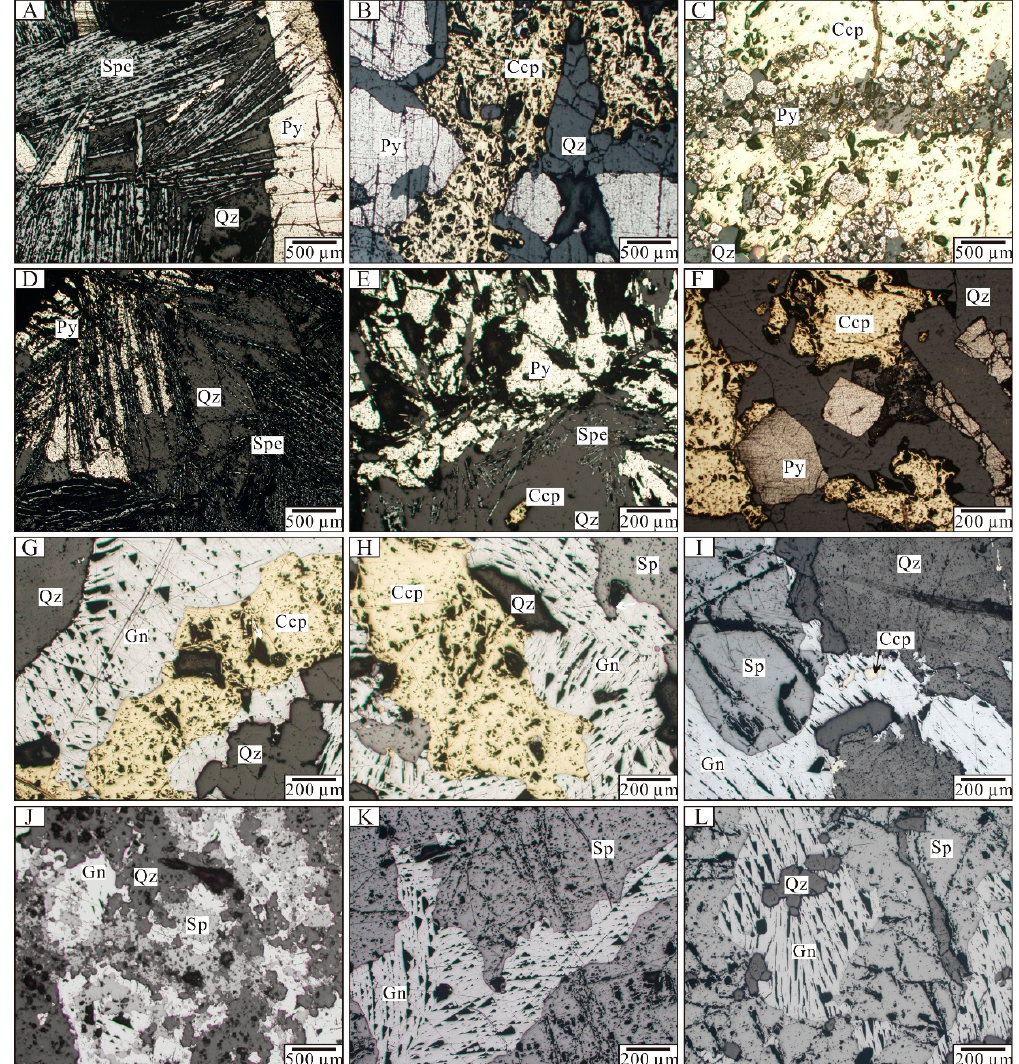
Figure 6. Photomicrographs showing the important mineral assemblages in the Qibaoshan polymetallic ore field. ( A ) Euhedral pyrite replaced by specularite in the Jinxiantou deposit; ( B , C ) Pyrite replaced by chalcopyrite in the Jinxiantou deposit; ( D , E ) Euhedral pyrite replaced by specularite in the Changgou deposit; ( F ) Pyrite replaced by chalcopyrite in the Changgou deposit; ( G , H ) Chalcopyrite replaced by sphalerite and galena aggregate in the Changgou deposit; ( I , J ) Sphalerite and galena aggregate in the Xingshanyu deposit; and ( K , L ) Sphalerite replaced by galena in the Hongshigang deposit. Abbreviations: Qz (quartz); Py (pyrite); Spe (specularite); Ccp (chalcopyrite); Sp (sphalerite); Gn (galena).